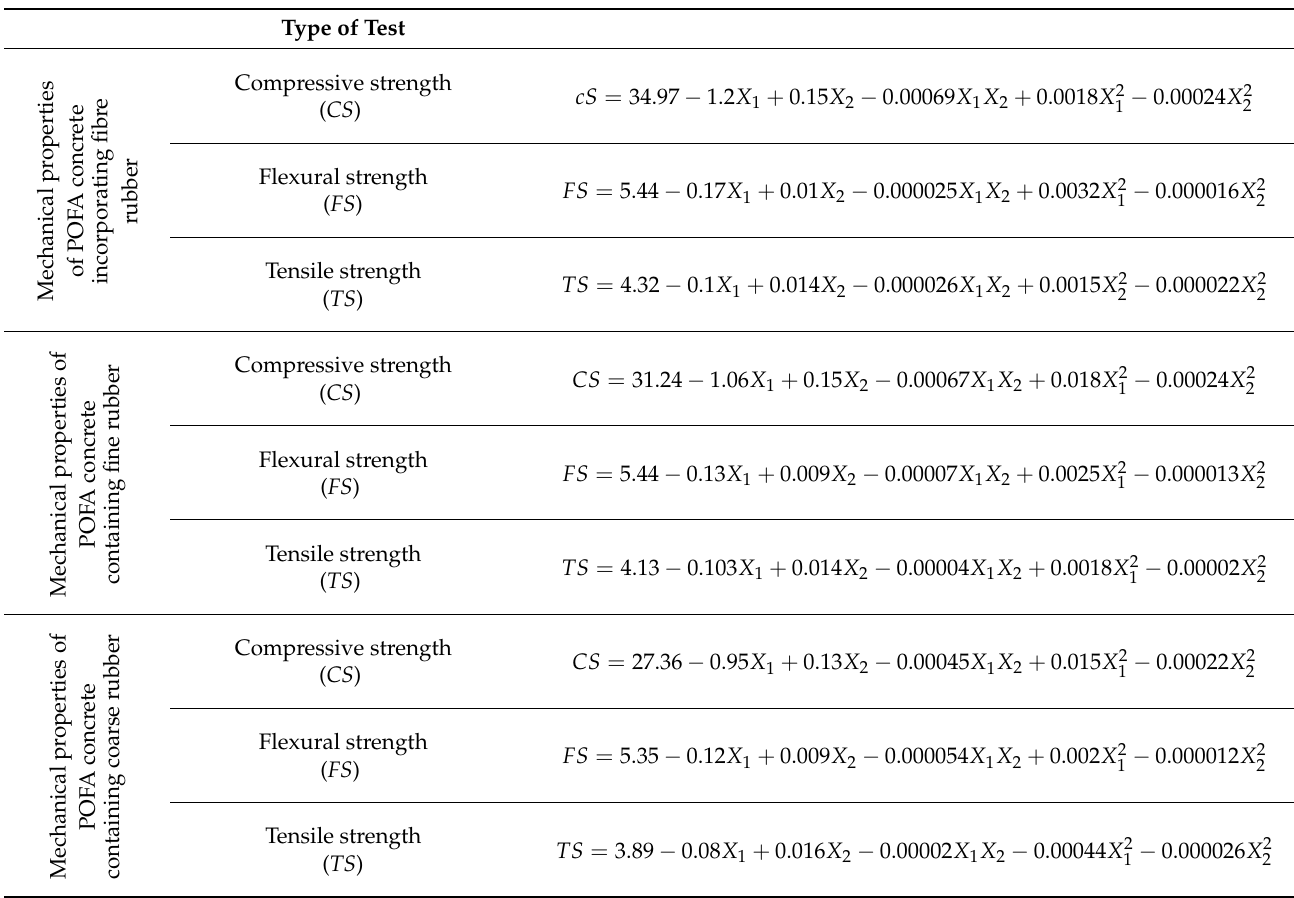
Table 6. Mathematical equations of the mechanical properties of POFA concrete containing fibre, fine, and coarse